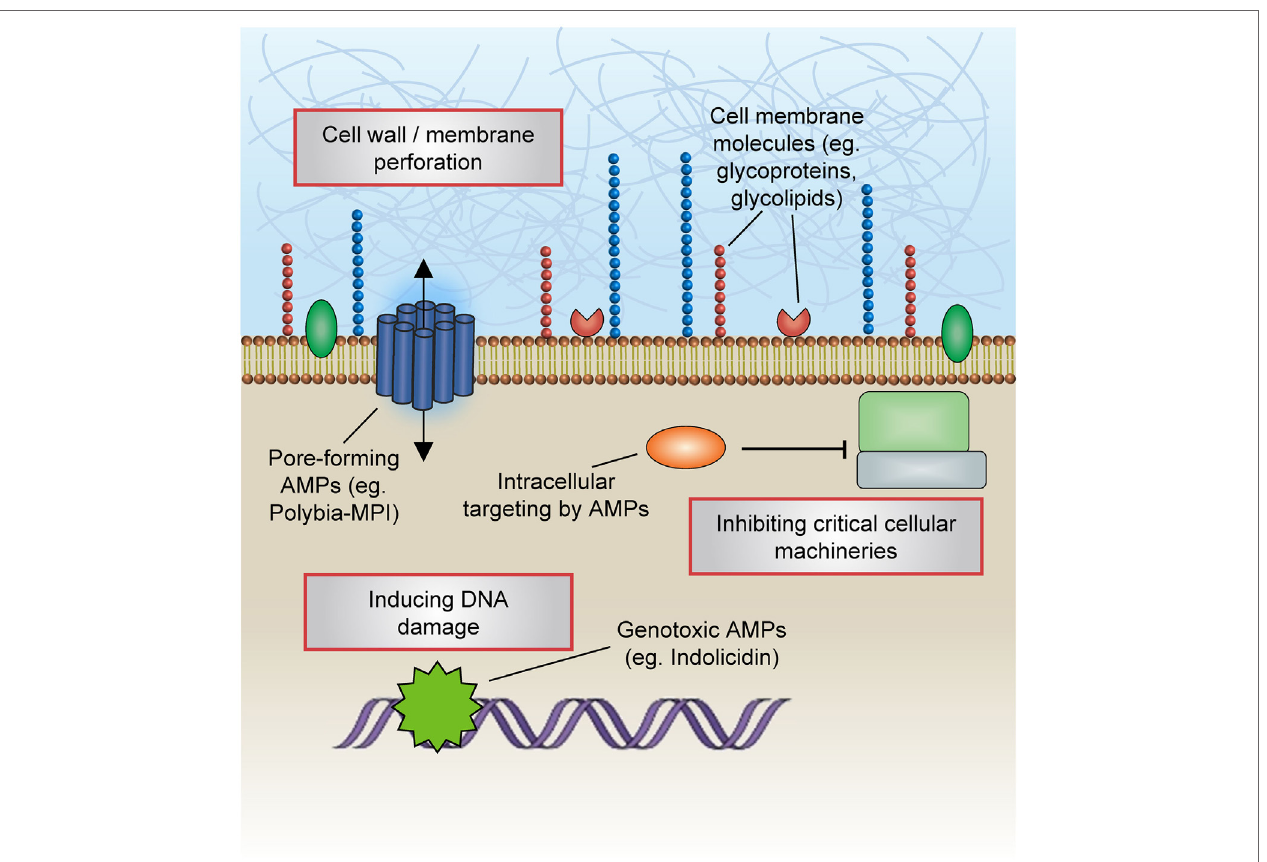
FiGURe 2 | Mechanisms of antimicrobial actions. Classical mechanisms which mediate the antibiotic actions of antimicrobial peptides (AMPs) include their penetration of the plasma membrane or cell wall, thus resulting in lysis or disruption of ionic gradients; binding to and damaging nucleic acids (e.g., DNA); and blockade of enzymes essential for maintaining the integrity of microorganisms’ cell